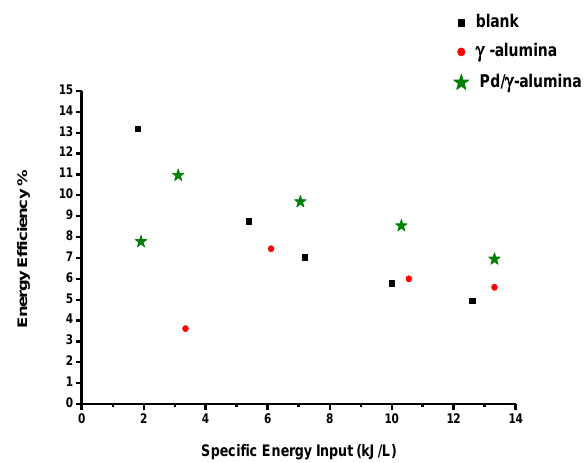
Figure 7. Energy efficiency versus specific energy input for the blank reactor and the packed reactor with γ-alumina and 1 wt% Pd/γ-alumina. Total flow rate = 50 ml/min, f = 23 kHz.